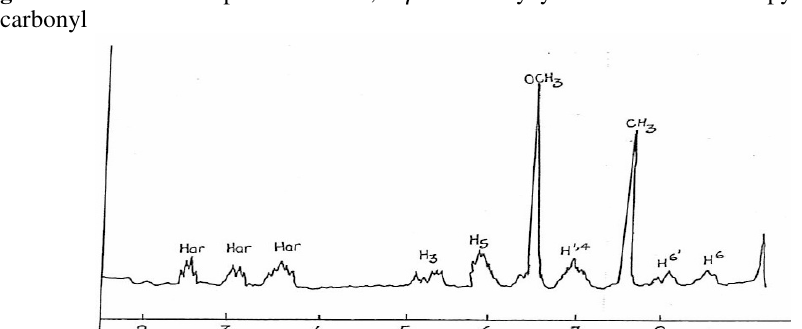
Figure 1. 1 H NMR spectrum of 1,4- η -2-methoxycyclohexa-1-3-diene- N -pyridino iron tricarbonyl